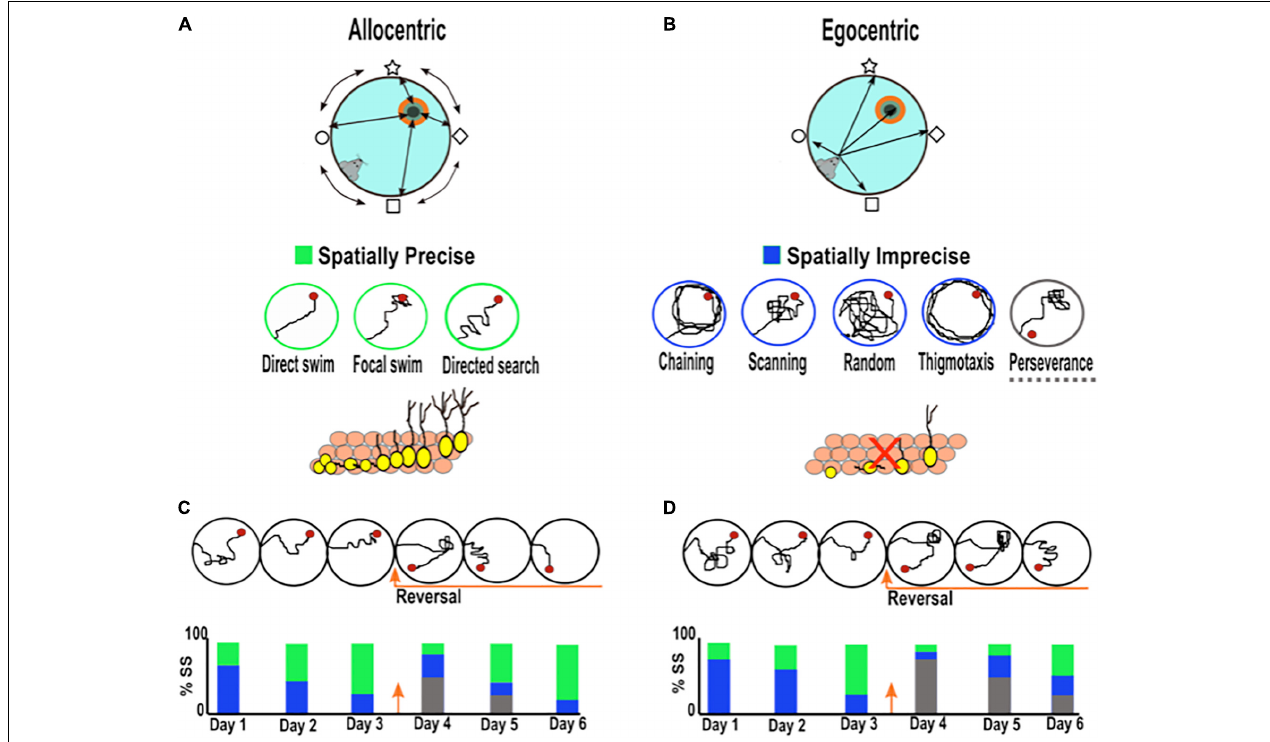
FIGURE 1 | Searching strategies used by rodents during spatial learning in the Morris water maze. (A) Spatial allocentric strategy (object to object) is characterized by the ability to navigate using distal cues located outside the maze and at some distance from the rodent. The bottom panel shows representative examples of three allocentric search strategies listed from most precise to least precise (direct swim → focal swim → directed search), which have been related to AHN. (B) Non-spatial egocentric strategy (self to object) characterized by the ability to navigate using internal cues independent of external cues based on a sequence of bodily movements. The bottom panel presents representative examples of six spatially imprecise egocentric search strategies (chaining, scanning, random, thigmotaxis, and perseverance). The decrease in AHN has been related to more imprecise search strategies. (C,D) Example of the search strategies adopted by rodents with normal (C) and low levels of neurogenesis (D) . The bottom bar charts illustrate the percentage of search strategies employed by rodents across training. Green bar: spatially precise search. Blue bar: spatially imprecise search. Gray bar: perseverance search. Rodents with low hippocampal neurogenesis require more training days before they begin to use spatially precise search strategies (green) than rodents with normal neurogenesis. When the platform changes to a new location, rodents with low neurogenesis spend more time searching over the old platform location (perseverance; gray bar) and adopt more imprecise search strategies (blue) than